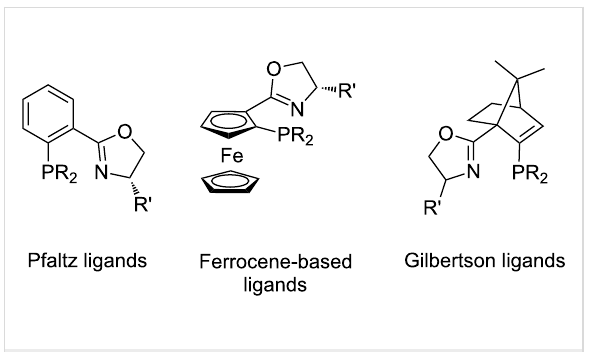
Figure 2: Chiral phosphanyl-oxazoline (PHOX) ligands used for inter- molecular asymmetric Heck